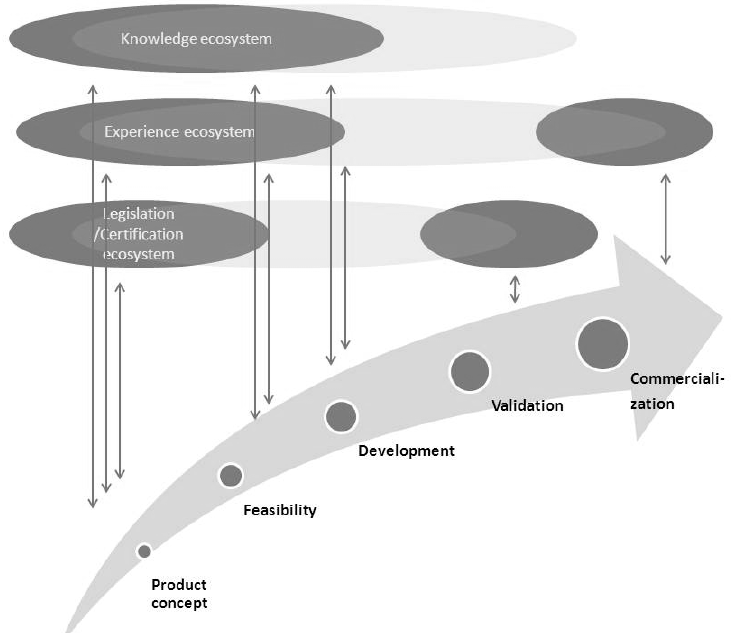
Fig. 4 . Stage-gate process interacting with the